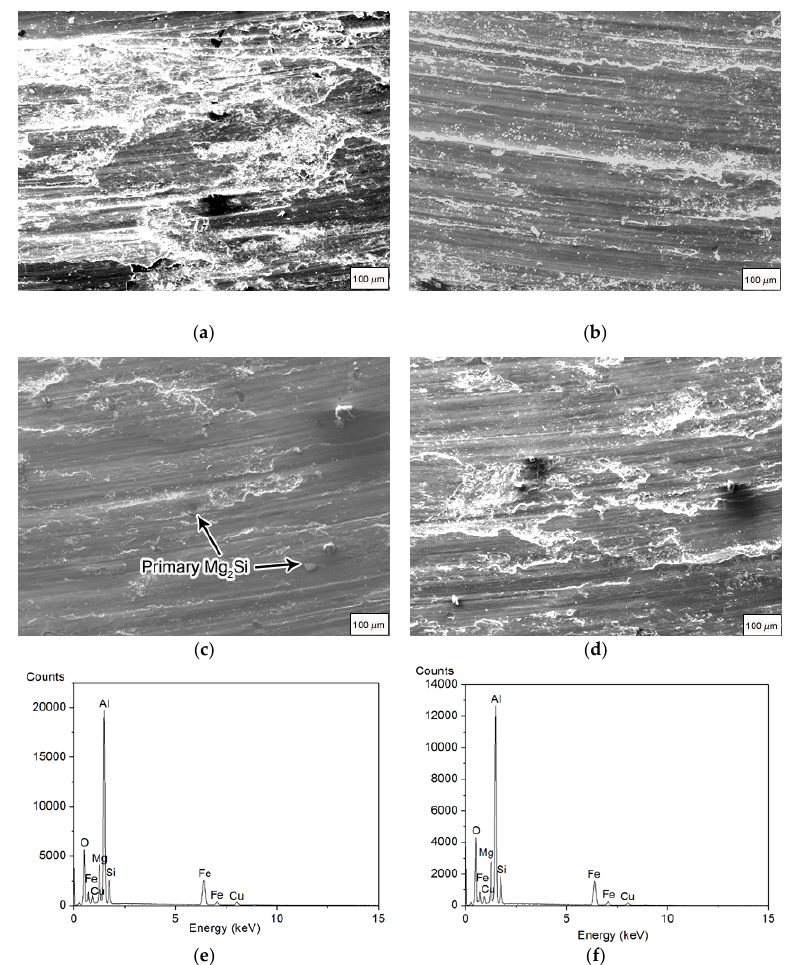
Figure 5. SEM and EDS results of the wear surfaces of Mg 2 Si–Al composites with 50 N applied load. ( a ) Gravity casting, ( b ) semi-solid extrusion with isothermal heat treatment holding time of 50 min, ( c ) semi-solid extrusion with isothermal heat treatment holding time of 60 min, ( d ) semi-solid extrusion with isothermal heat treatment holding time of 160 min, ( e ) EDS result of Mg 2 Si–Al composites fabricated by using gravity casting, and ( f ) EDS result of Mg 2 Si–Al composites fabricated by using semi-solid